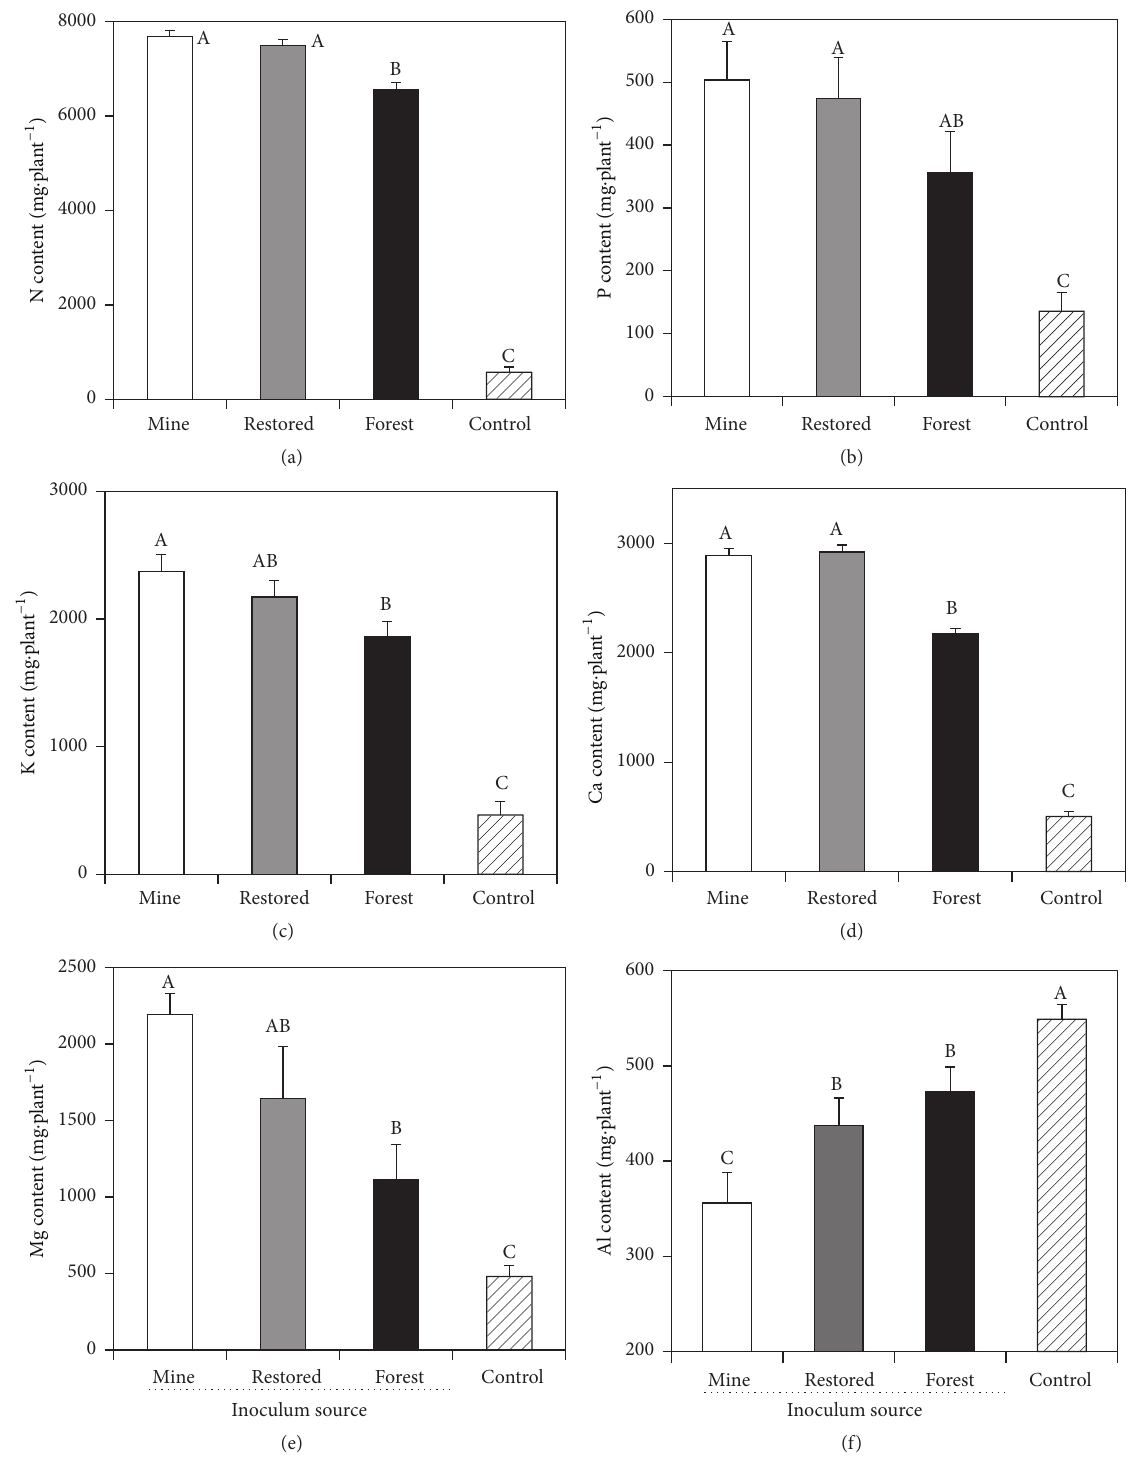
Figure 2: Effect of inoculation with mine, restored, or forest site Pisolithus ecotype on the mean foliar N (a), P (b), K (c), Ca (d), Mg (e), and Al levels (f) in Eucalyptus plants in the pot trial. Vertical bars indicate the standard error of the mean. For each nutrient, mean levels with the same letter do not differ significantly at 𝑝 < 0.05